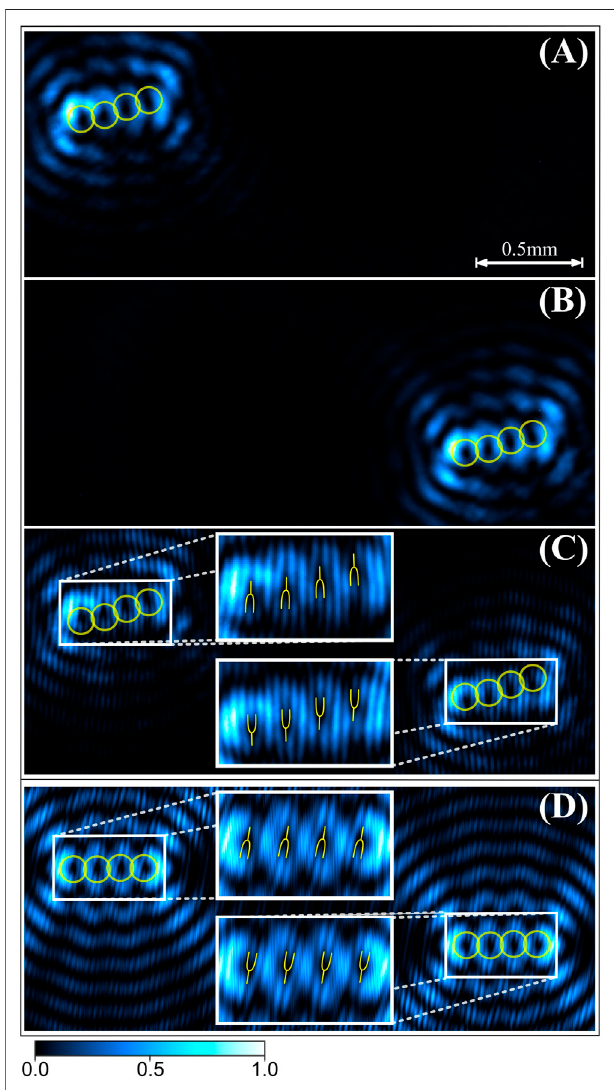
FIGURE 5 | Illustration of the phase analysis for the CBL generated with FWM. (A) and (B) display the intensity pro fi le of both arms in the Michelson – Morley interferometer for spatial reference. (C) Image of the experimental interference pattern with its main features zoomed at the insetswithwhiteframe. (D) PatternmodelingthepropagationoftheCBLarms with their Fresnel integral throughout their respective optical paths.